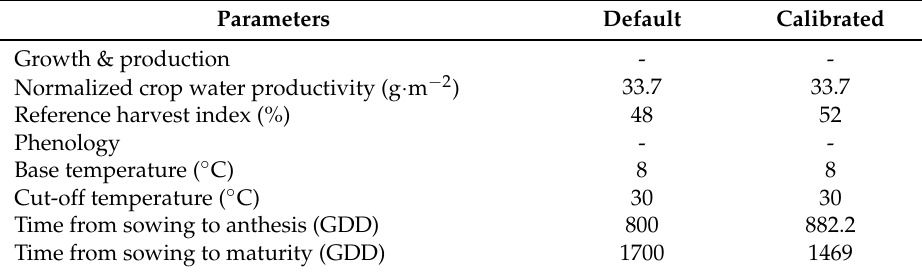
Table 3. AquaCrop default values and calibrated values for main parameters used in maize